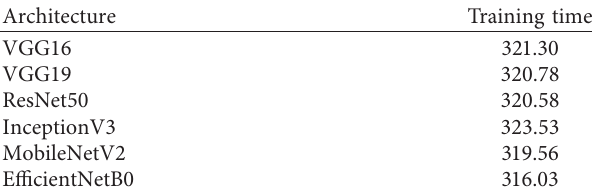
Table 4: Comparison of the training